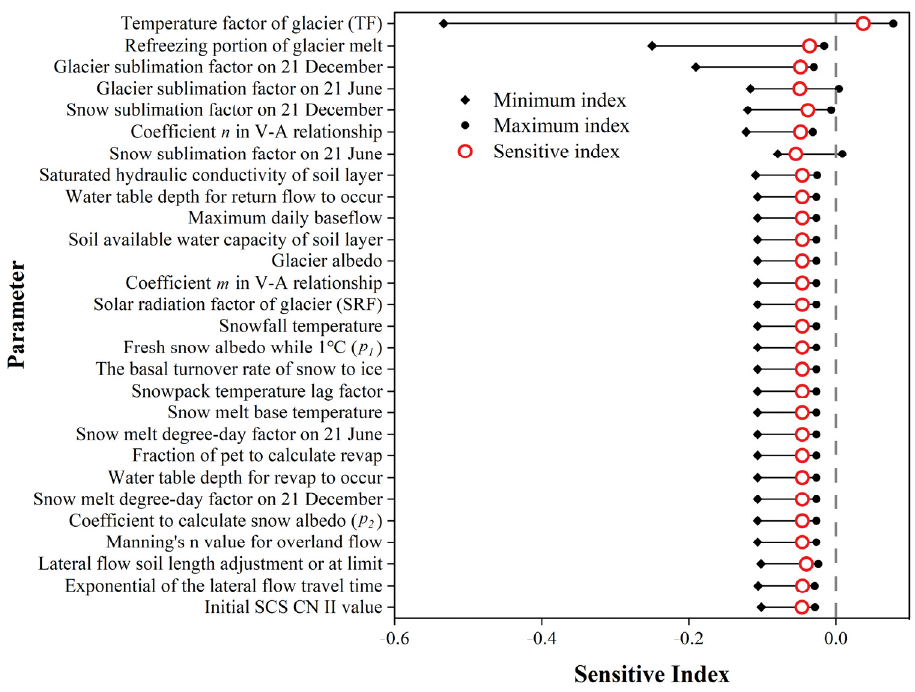
Figure 3. Parameter sensitivity scores in the UYR basin using Sobol method.